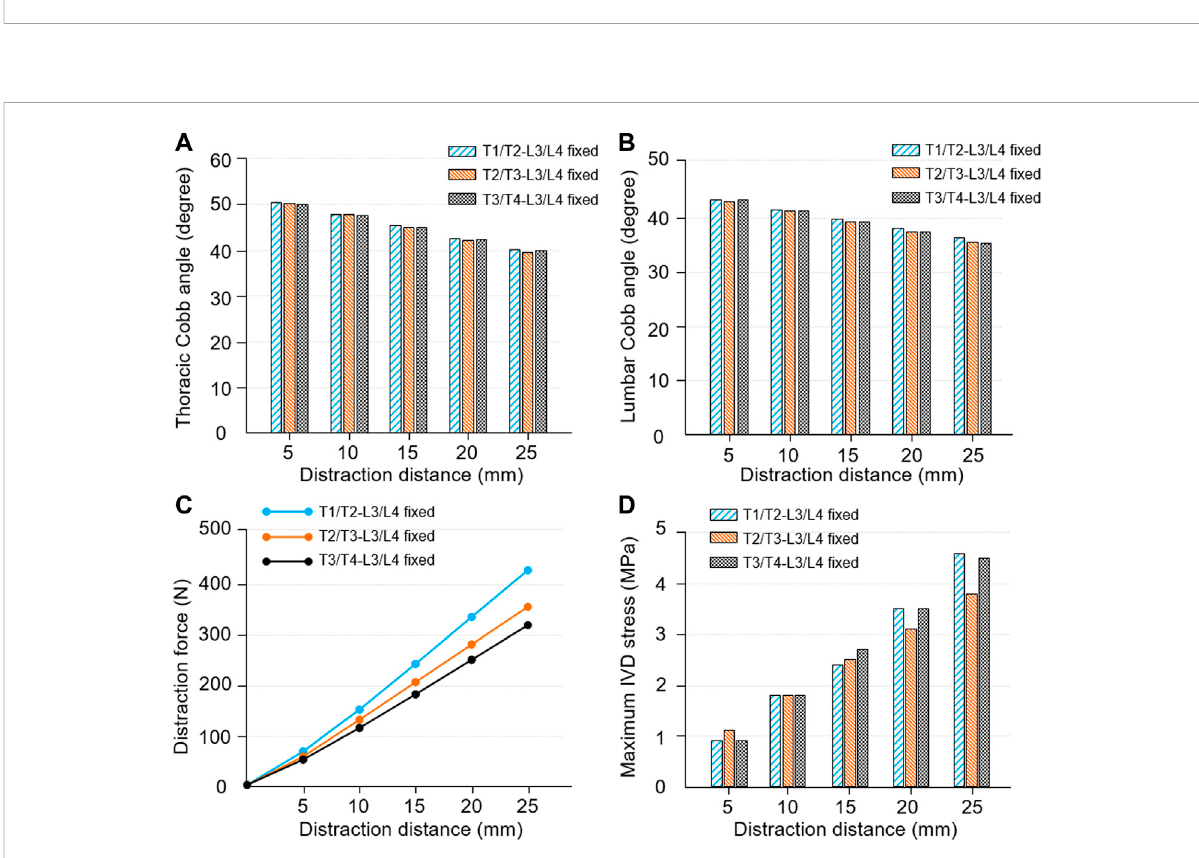
FIGURE 11 Spinal kinematic and mechanical responses in different fi xed modes. (A) The changes of thoracic Cobb angle as the distraction distance increased. (B) The changes of lumbar Cobb angle as the distraction distance increased. (C) The relationship between distraction distance and distraction force. (D) The relationship between distraction distance and maximum IVD